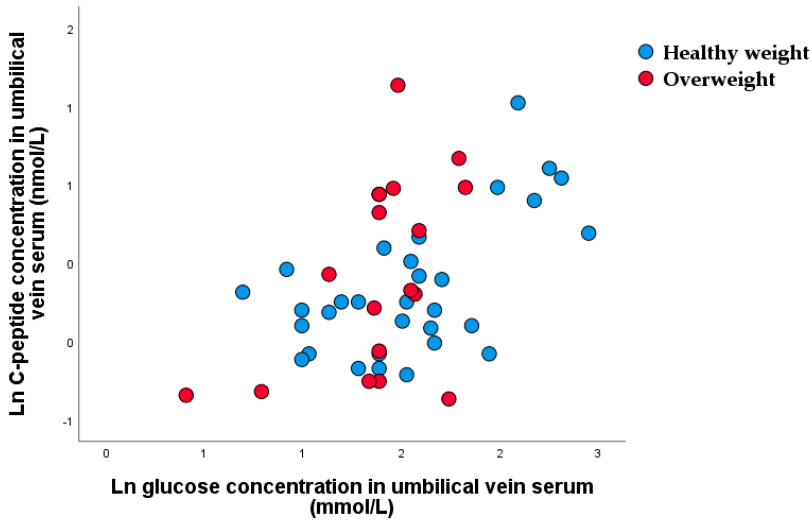
Figure 4. Scatter plot of nonparametric correlations between glucose and C-peptide concentrations in umbilical vein serum (r rho = 0.449, p < 0.001). Significant nonparametric correlations were demonstrated between maternal BMI and leptin concentration at the time of delivery (r rho = 0.501, p < 0.001) (Figure 5).